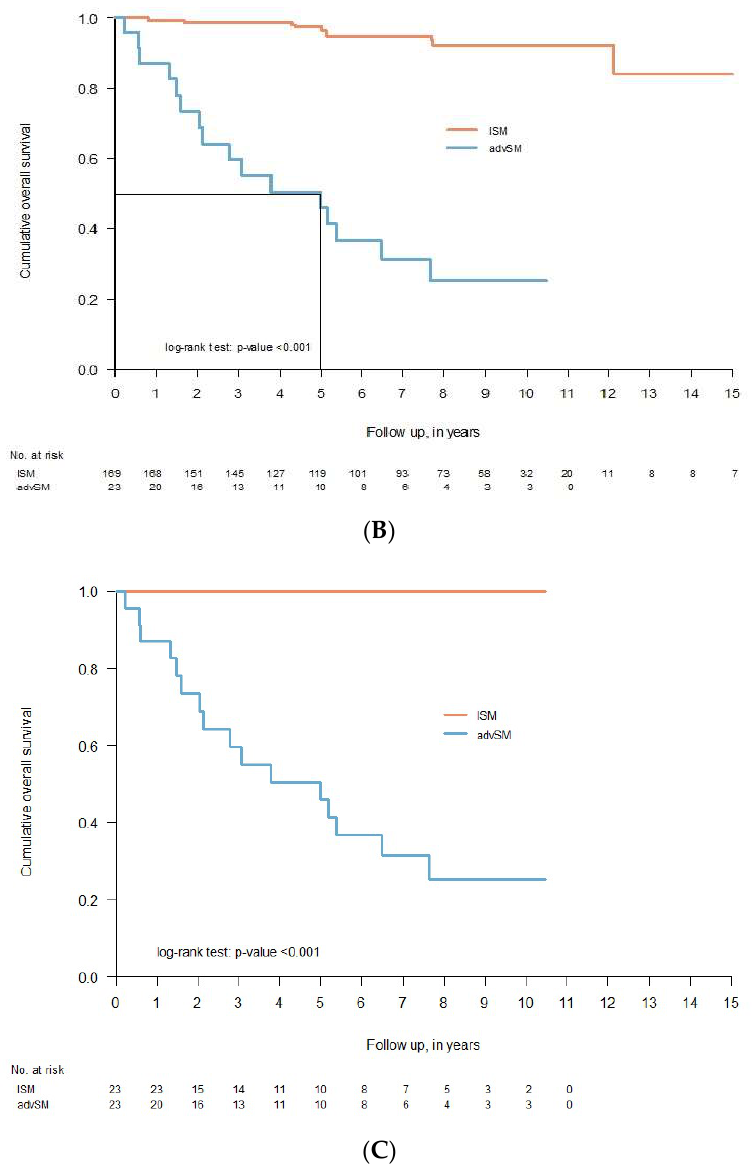
Figure 3. Overall survival of patients with systemic mastocytosis as determined by the log-rank test: Kaplan–Meier estimates of overall survival for ( A ) the full cohort of patients with systemic mastocytosis and ( B ) stratified by ISM vs. AdvSM, and ( C ) age-matched propensity score stratified by ISM vs. AdvSM.